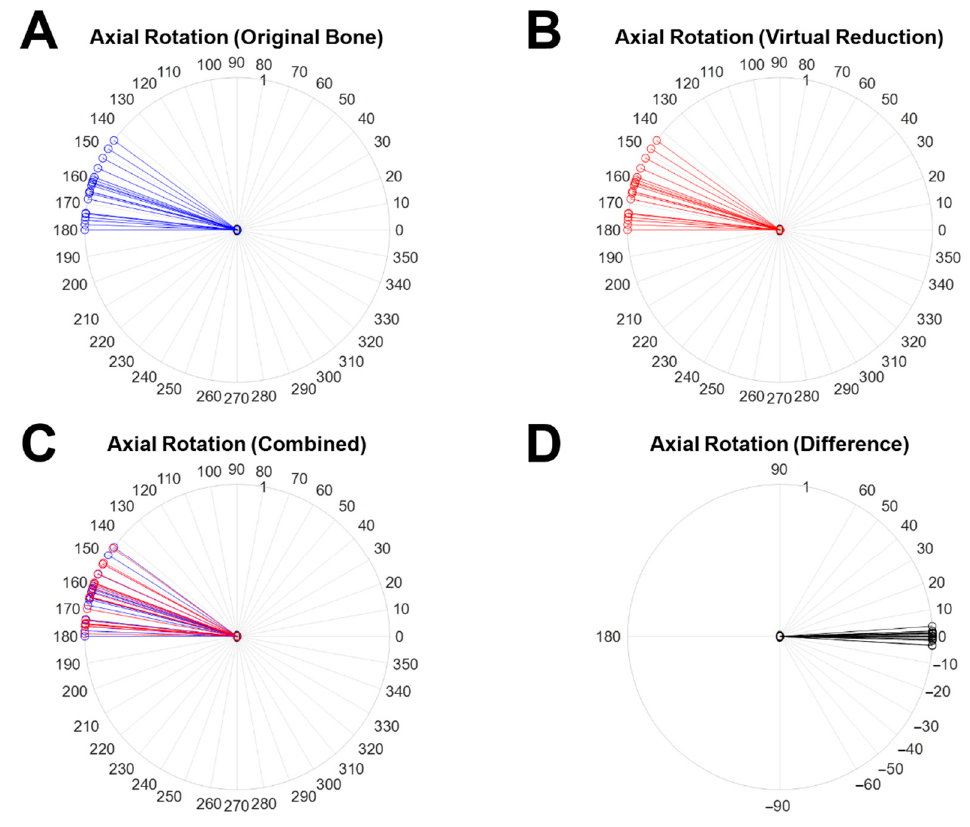
Figure 9. The measured 2D angle of axial rotation in the XY plane using 3D angulation and the variation between the original object and the virtually reduced bone. ( A ) The axial rotation measured from the angle between Normal Vector 1 and Normal Vector 2 (the original object), ( B ) the axial rotation measured from the angle between Normal Vector 1 and Normal Vector 2 ′ (the virtually reduced object), ( C ) the overlapped results for ( A ) with blue lines and ( B ) with red lines, and ( D ) the difference (black line) in axial rotation between ( A ) with blue lines and ( B ) with red lines.